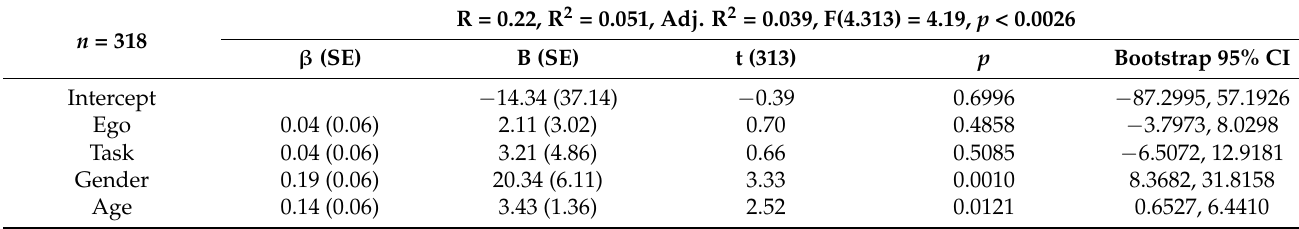
Table 8. Regression model for experience in undertaking physical activity (duration of exercise in months). n =